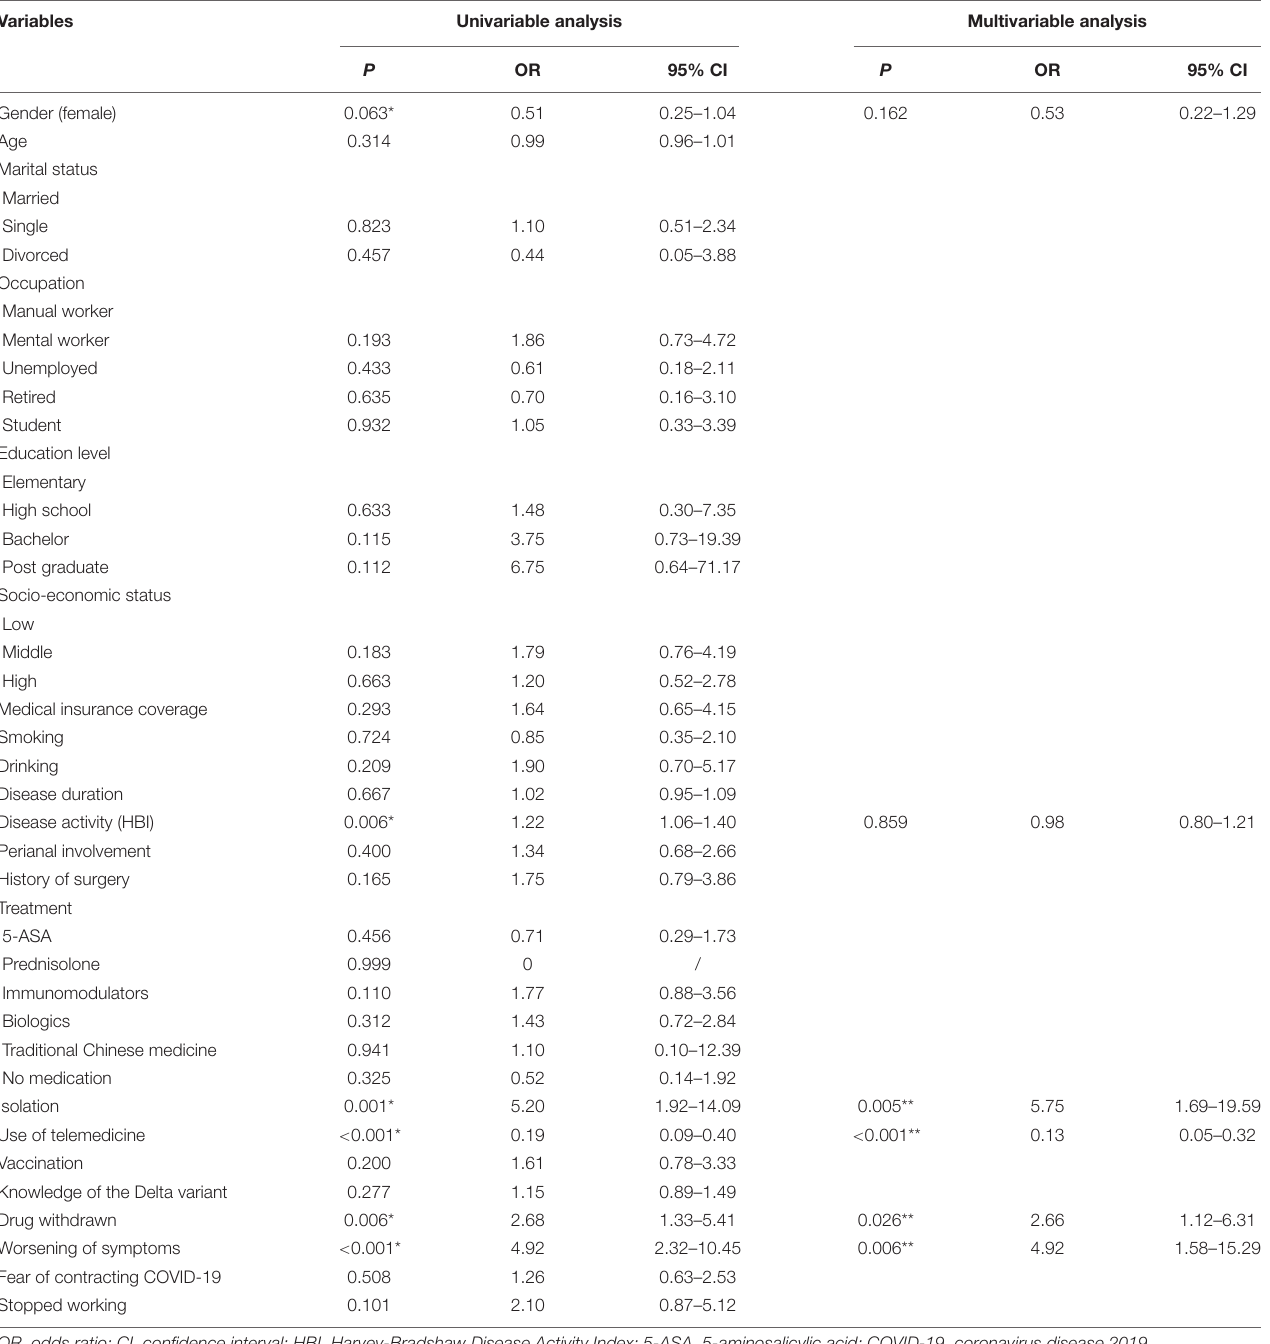
TABLE 5 | Factors associated with elevated